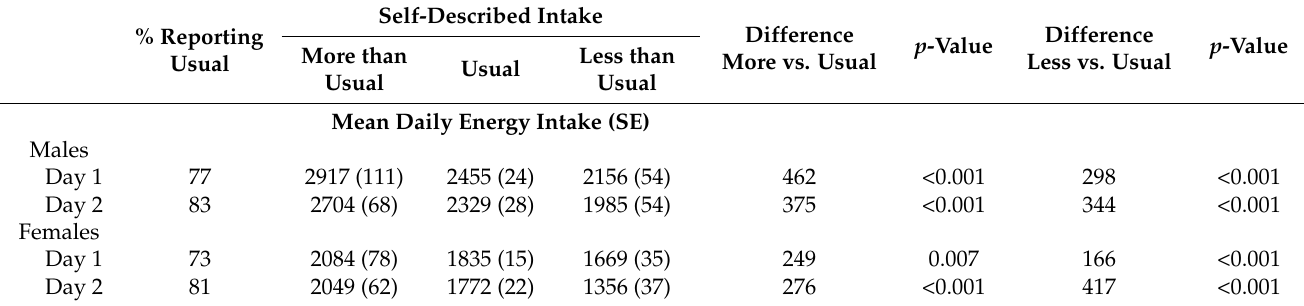
Table 3. Mean daily energy intakes by self-described intake, sex, and intake day for U.S. adults age 20+, WWEIA, NHANES 2013–2016 1